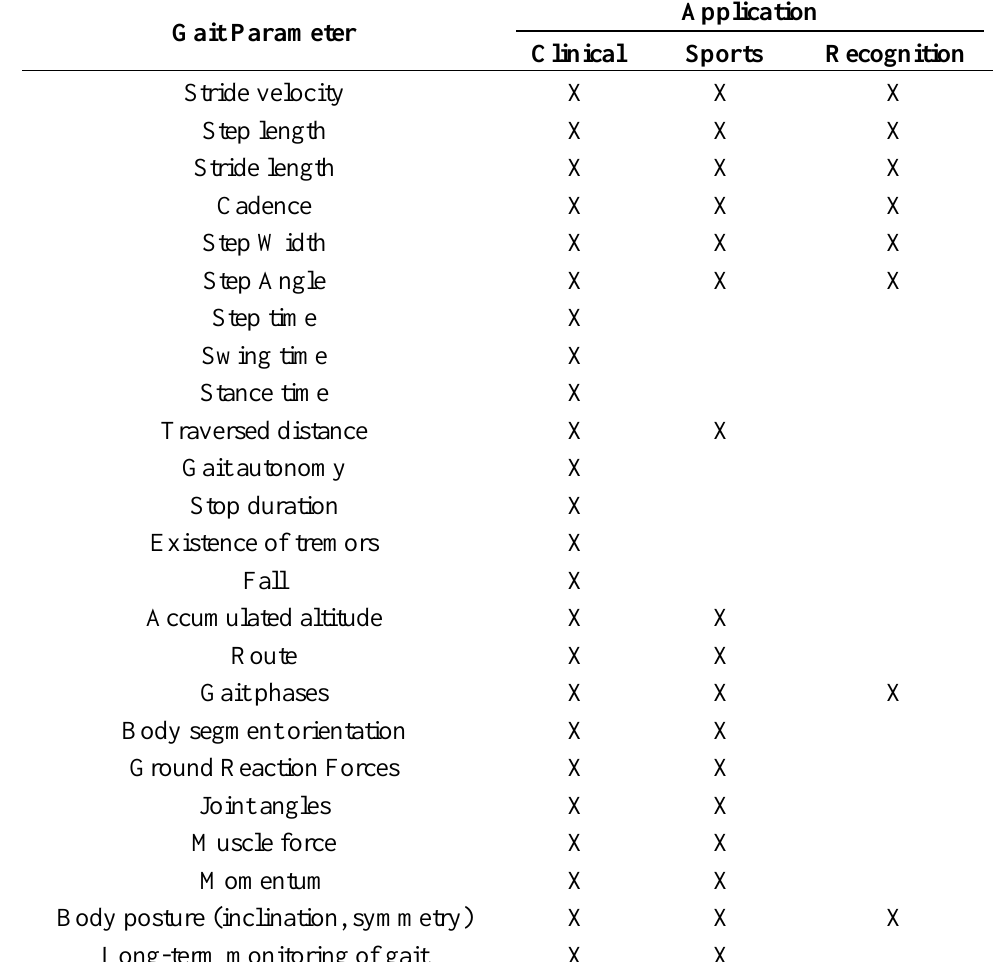
Table 1. Overview of gait parameters and